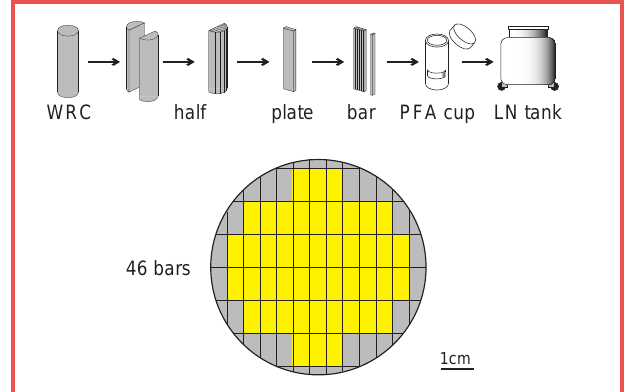
Figure 4. An example of frozen whole round core (WRC) subsampling. The WRC is first cut in half lengthwise, then one half is sectioned into plates, and each plate is cut into bars. Cut core samples are put in PFA cups and stored in a liquid nitrogen tank at -160ºC (or deep freezer at